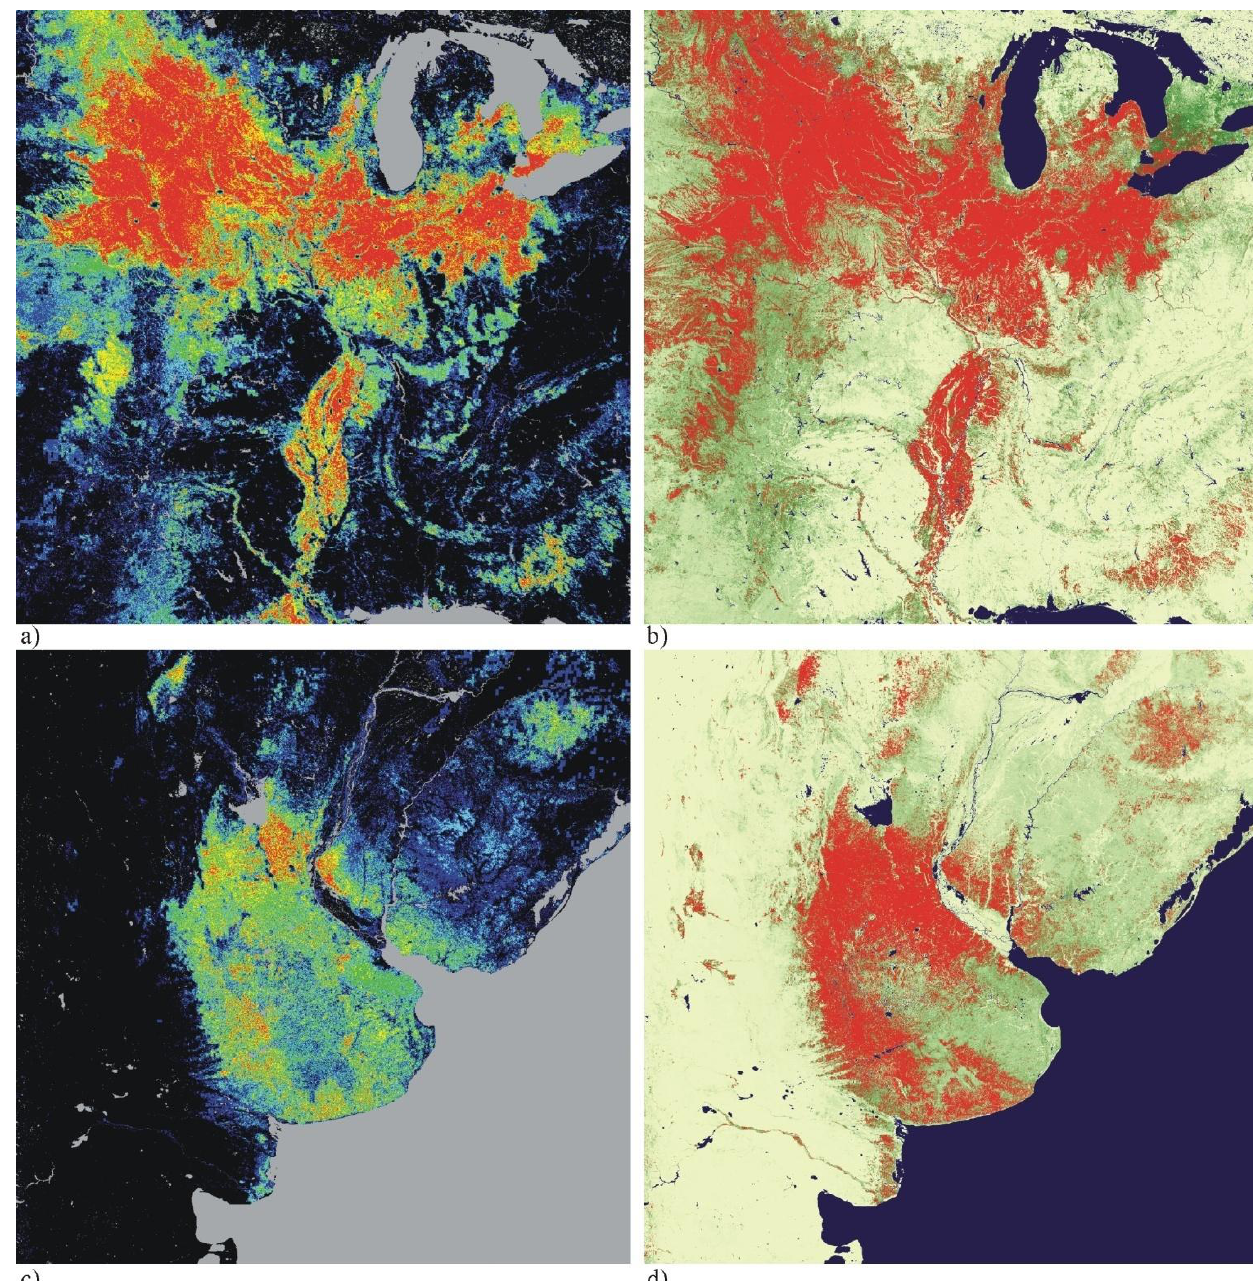
matched the FAS PSD cropland area estimates. Probability of cropland class membership below the matching threshold is shown in green. For example, an adaptable use of the threshold could be used to delineate more of the rice growing regions along the lower Yangtze River in China (Figure 6f). Figure 6. For (a) U.S. Corn Belt, (c) Argentina/Uruguay/Brazil, (e), North China Plain, and (g) Pakistan/India/China, agreement amongst five heritage cropland data sets, where red equals 5 out of 5 agreement, orange equals 4 out 5, green 3 out of 5, cyan 2 out of 5, and blue 1 out of 5. For the same respective regions in (b), (d), (f), (h), MODIS 250 m global cropland product based on per country matching thresholds. Final cropland extent is shown in red, with probability values outside of final mask shown in green. Each subset is 1,843 km by 1,843 km in